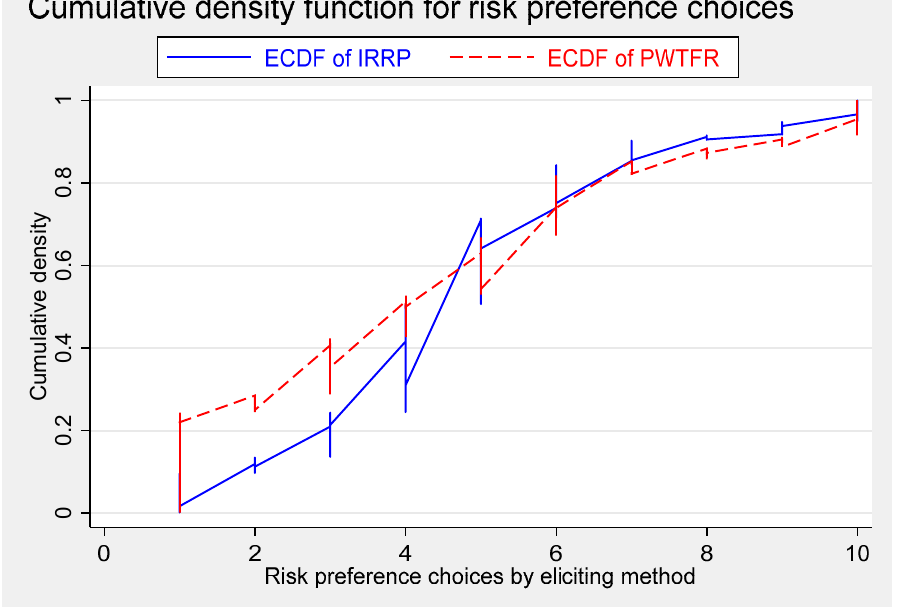
IRRP approach and not provided in the PWTFR method.